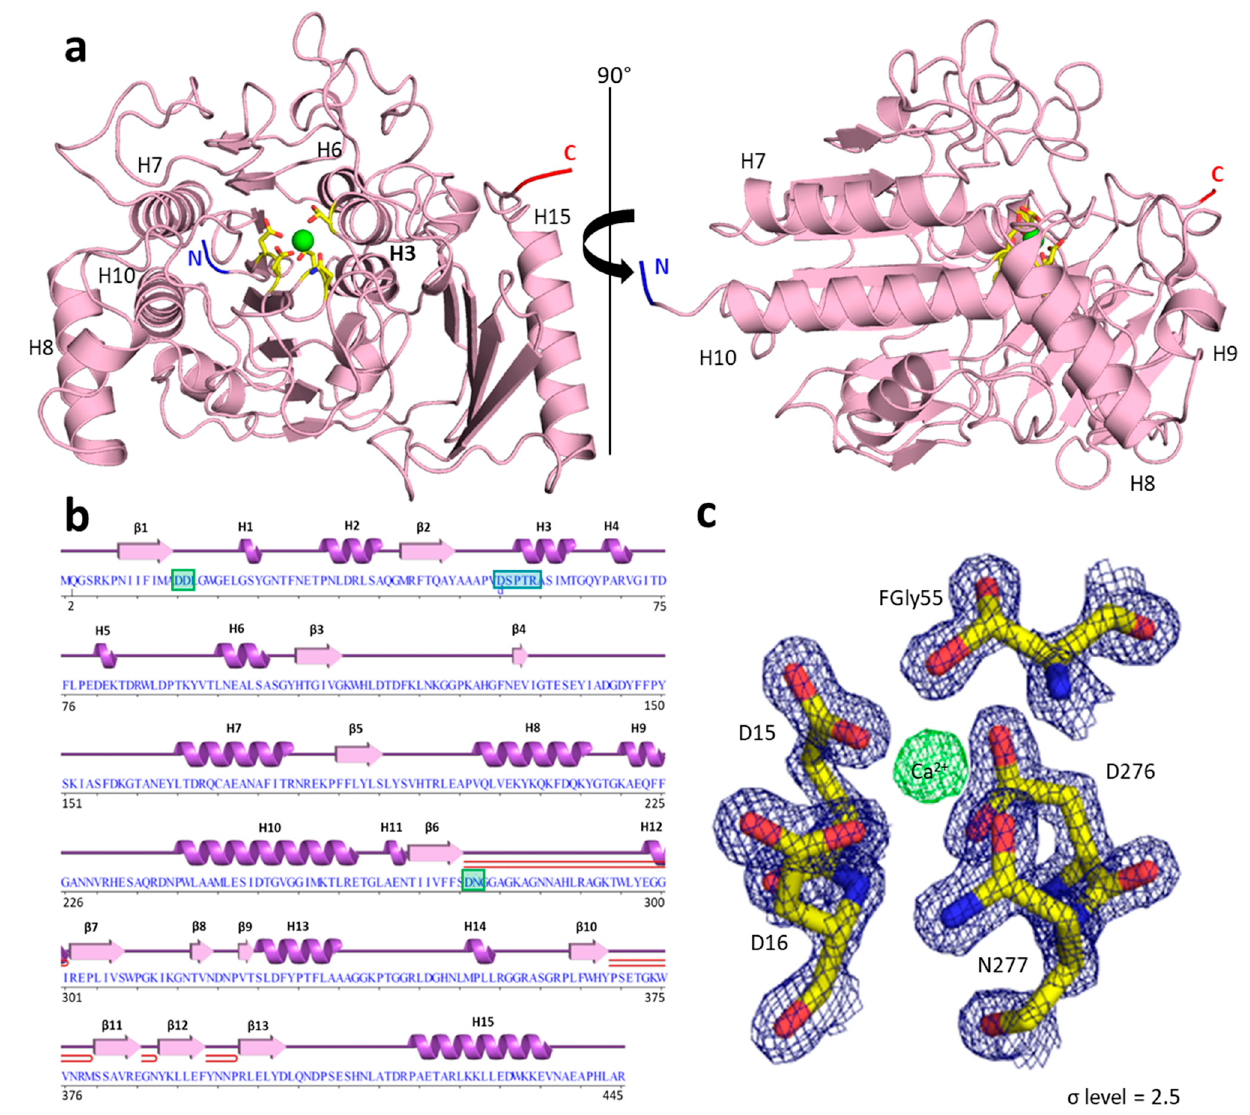
Figure 2. ( a ) Crystal structure of PyuS calcium (green) bound in the active site (PDB code: 7STT). Residues coordinating the calcium ion are shown in yellow. The N- and C-termini are colored in blue and red, respectively. The formylglycine residue is located in helix 3 ( H3 ). ( b ) Amino acid sequence and corresponding secondary structural elements of PyuS with labeled α -helices (H) and β -strands ( β ). The β -hairpins are shown in red. Metal-coordinating residues are highlighted in green. The sulfatase FG motif is highlighted in cyan, and FGly is annotated with a lowercase “d”. ( c ) Electron density map (contoured at 2.5 σ ) of active site residues coordinating calcium (D15, D16, FGly55, D276, and N277). In the density, the FGly residue can clearly be seen as a hemi-acetal side chain rather than a 2-amino-3-oxopropanoic